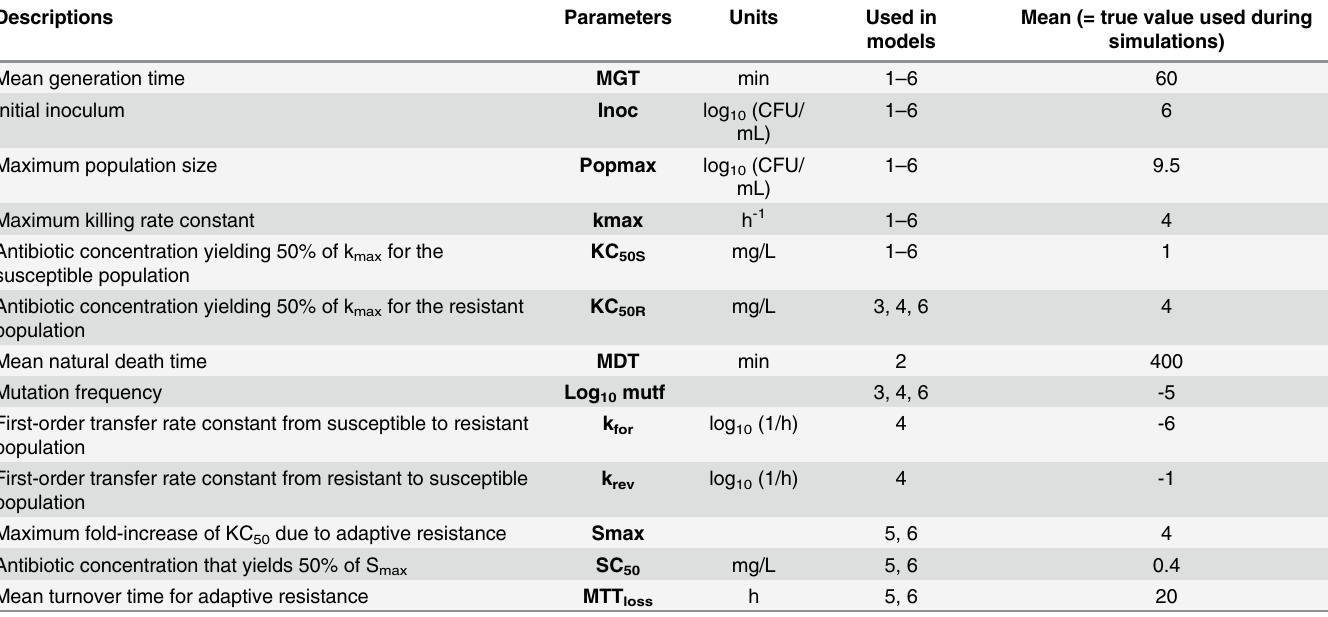
Mean (= true value used during models